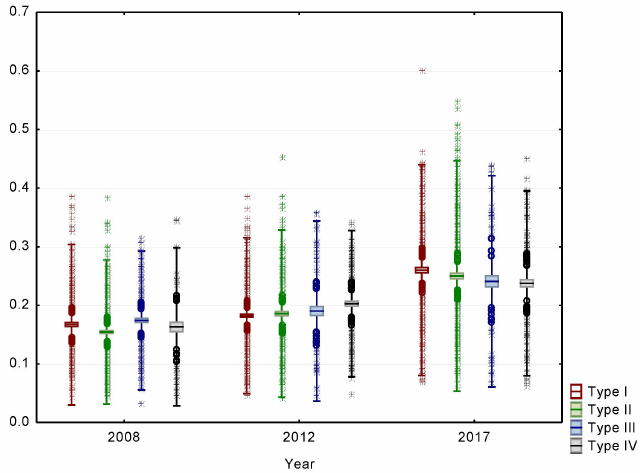
Figure 2. Box plot for TRF values in the studied years and in individual types of